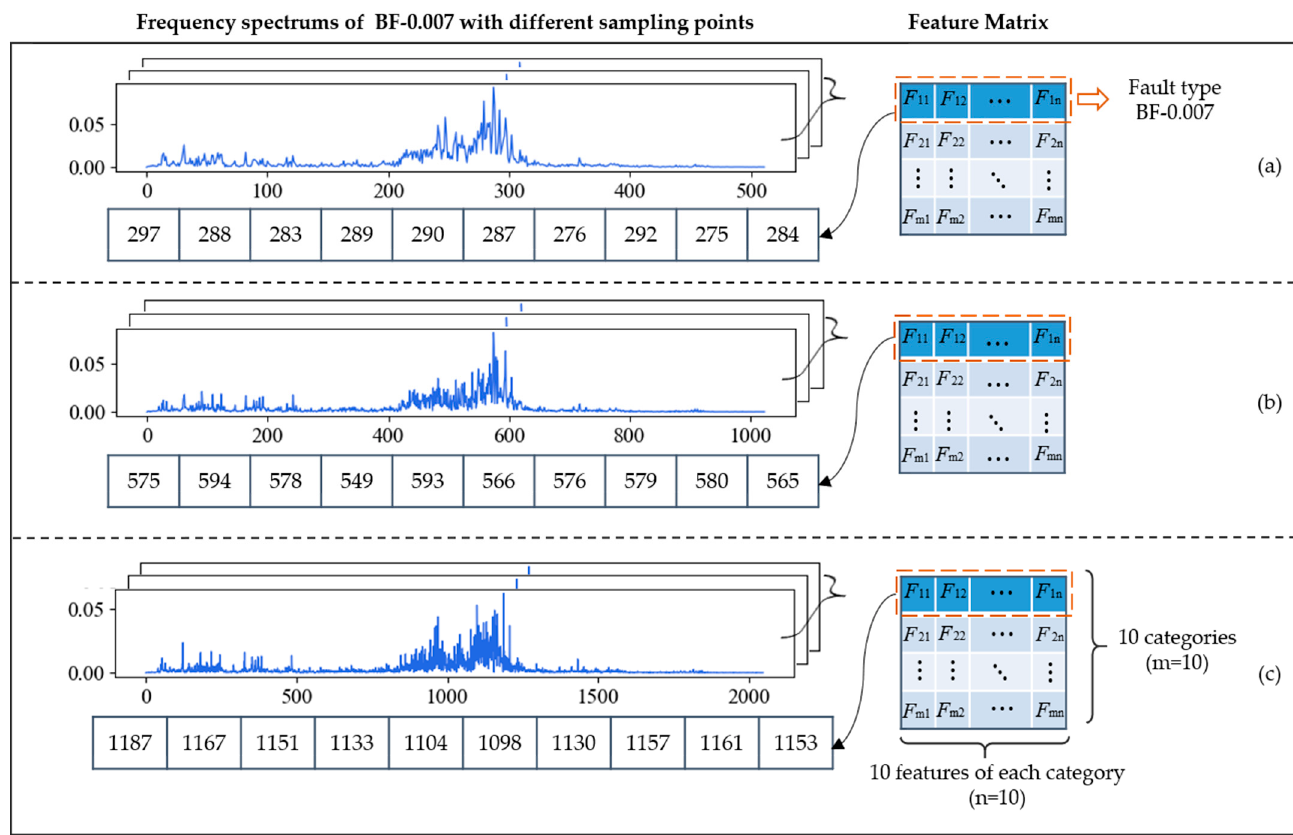
Figure 7. The frequency spectrums and ten feature frequencies of BF-0.007 with different sampling lengths: ( a ) 1024 points; ( b ) 2048 points; ( c ) 4096 points.